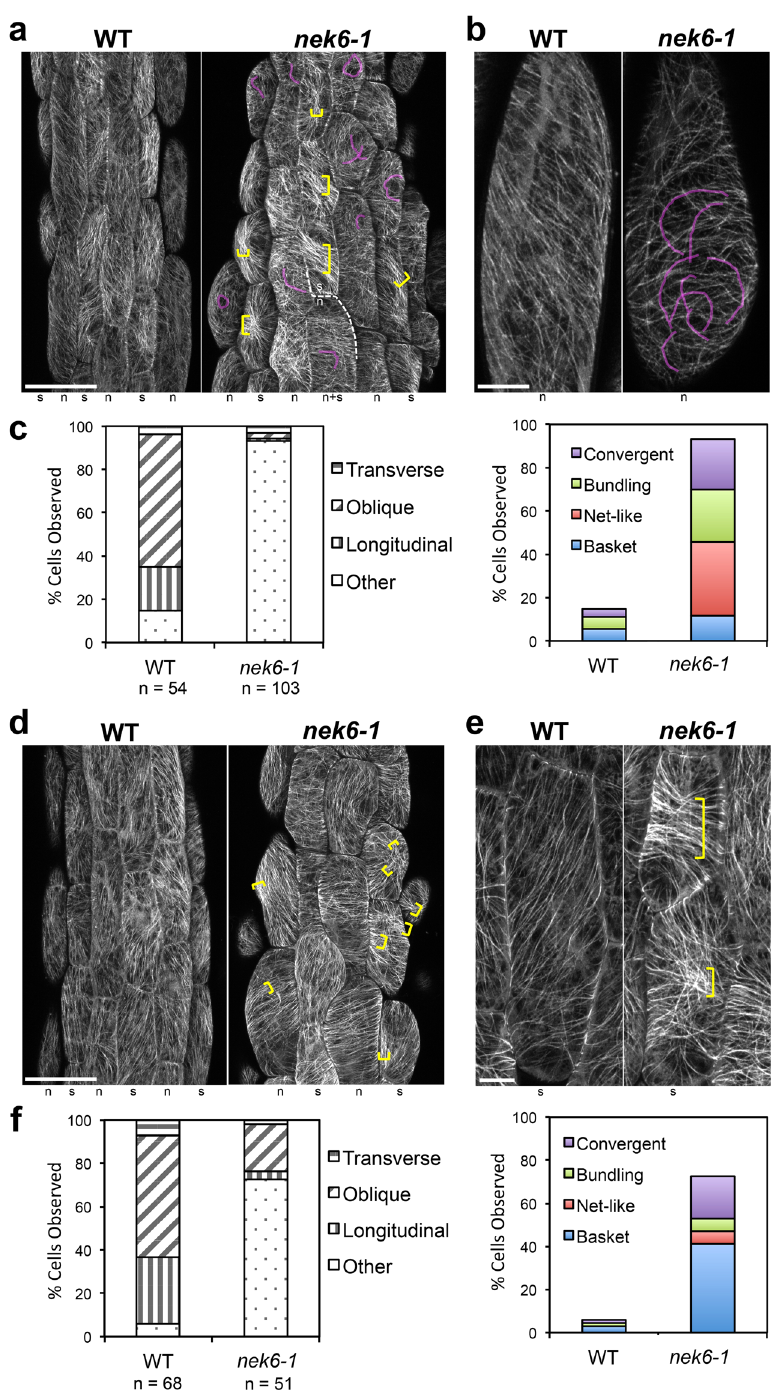
Figure 2. NEK6 regulates cortical microtubule organization during directional cell growth. Cortical microtubule organization visualized by GFP-TUB6 in hypocotyl epidermal cells of 3-day-old seedlings of wild type (WT) and nek6-1 mutant. ( a , b ) Cortical microtubules in the middle region of hypocotyl (No. 7–15 cells from bottom of hypocotyl). The representative cells in the non-stomatal cell files are shown in ( b ). ( c ) Quantification of cortical microtubule arrays in the middle region of hypocotyls. ( d , e ) Cortical microtubules in the basal region of hypocotyl (No. 1–6 cells from bottom of hypocotyl). The representative cells in the stomatal cell files are shown in ( e ). ( f ) Quantification of cortical microtubule arrays in the basal region of hypocotyls. In ( a , b ) and ( d , e ), light magenta lines highlight bended cortical microtubules and yellow brackets indicate microtubule bundling. At the bottom of each panel in ( a , b ) and ( d , e ), the stomatal and non-stomatal cell file is labeled as “s” and “n”, respectively. In ( c ) and ( f ), the left panels show the percentages of cells having transverse, oblique, or longitudinal arrays. In the right panels, cells with other arrangements are divided into four classes. Scale bars represent 50 µ m ( a , d ) and 10 µ m ( b , e